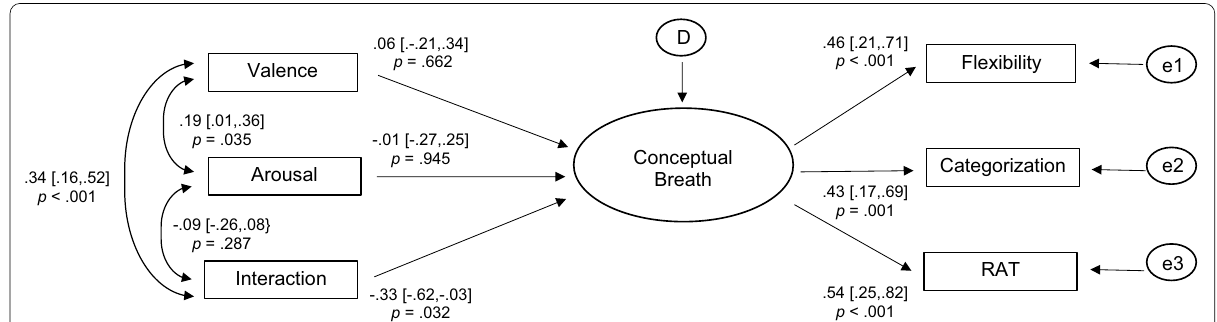
Fig. 2 Results from the structural equation model predicting the latent cognitive breadth factor using affect valence, arousal, and their interaction. Note. The large oval represents the latent conceptual breadth factor; small ovals represent residual error variances (“e”) or the regression residual (disturbance, “D”). Rectangles are measured variables. Flexibility Associates Test. Standardized parameters are shown, along 95% confidence intervals and p